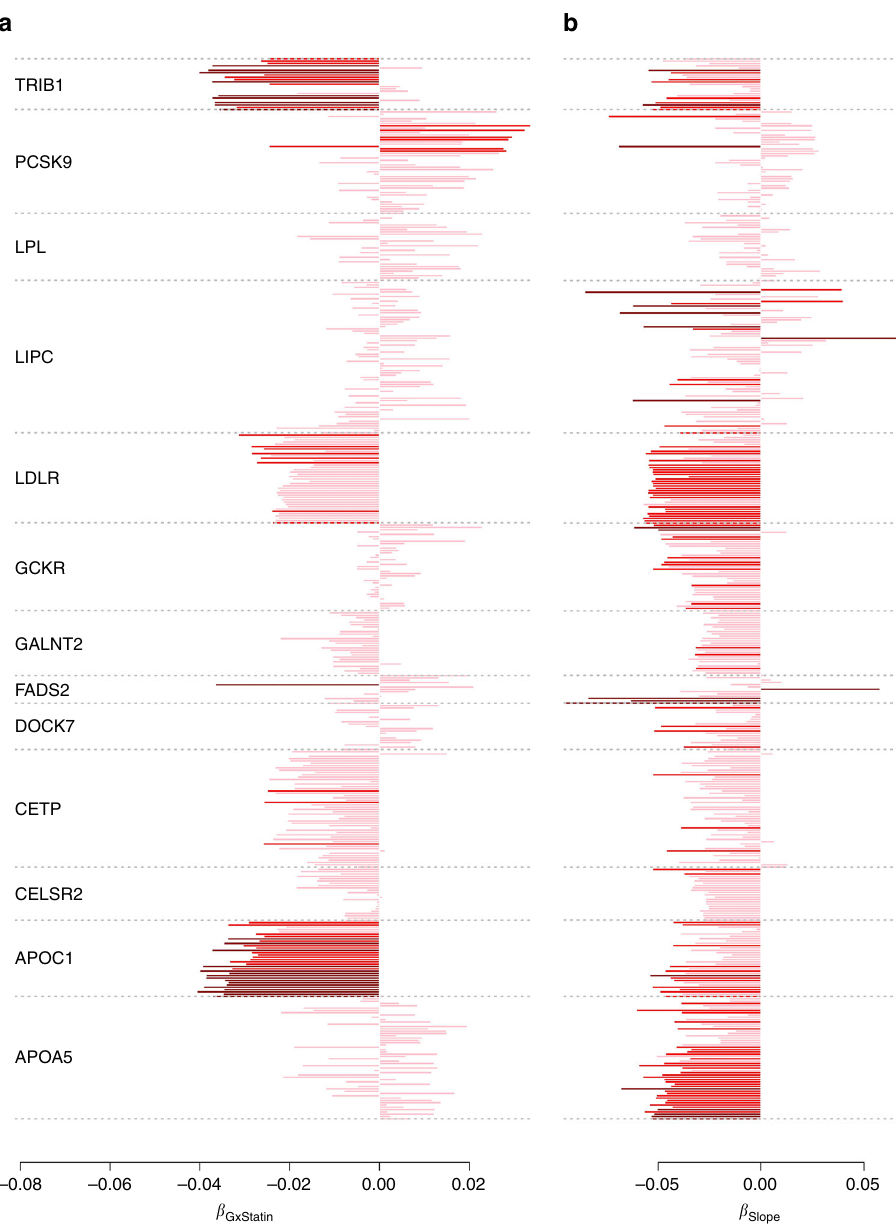
Fig. 6 Change in genetic effect as a function of aging and exposure to statins. We derived for the top variant of each of the 13 core regulator genes we identi fi ed, a the interaction effect with statin, and b the effect on Δ , the difference in the metabolite measurement between the two time points. In all bf association tests, the allele associated with an increase level of metabolite in the marginal test at baseline measurement was de fi ned as the coded allele. Non-signi fi cant test are in pink, test nominally signi fi cant are in red, and test signi fi cant at 5 × 10 − 3 are in dark red. In agreement with the heritability analysis most of the coef fi cients for Δ are negative, indicating an overall decrease of genetic effect. Two genes, APOC1 and TRIB1 , show strong enrichment bf for interaction with